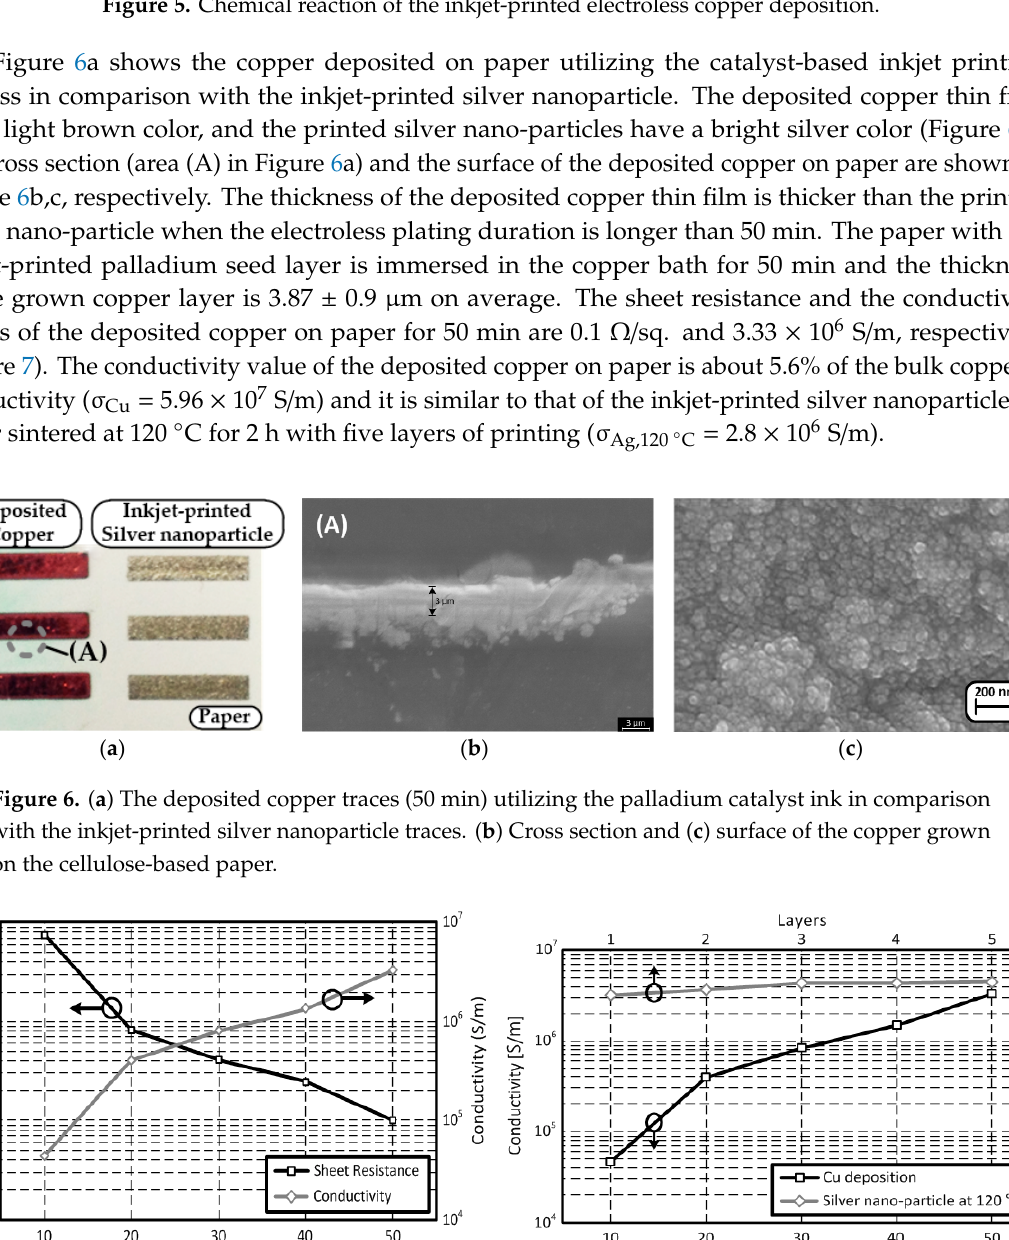
Figure 5. Chemical reaction of the inkjet-printed electroless copper deposition.